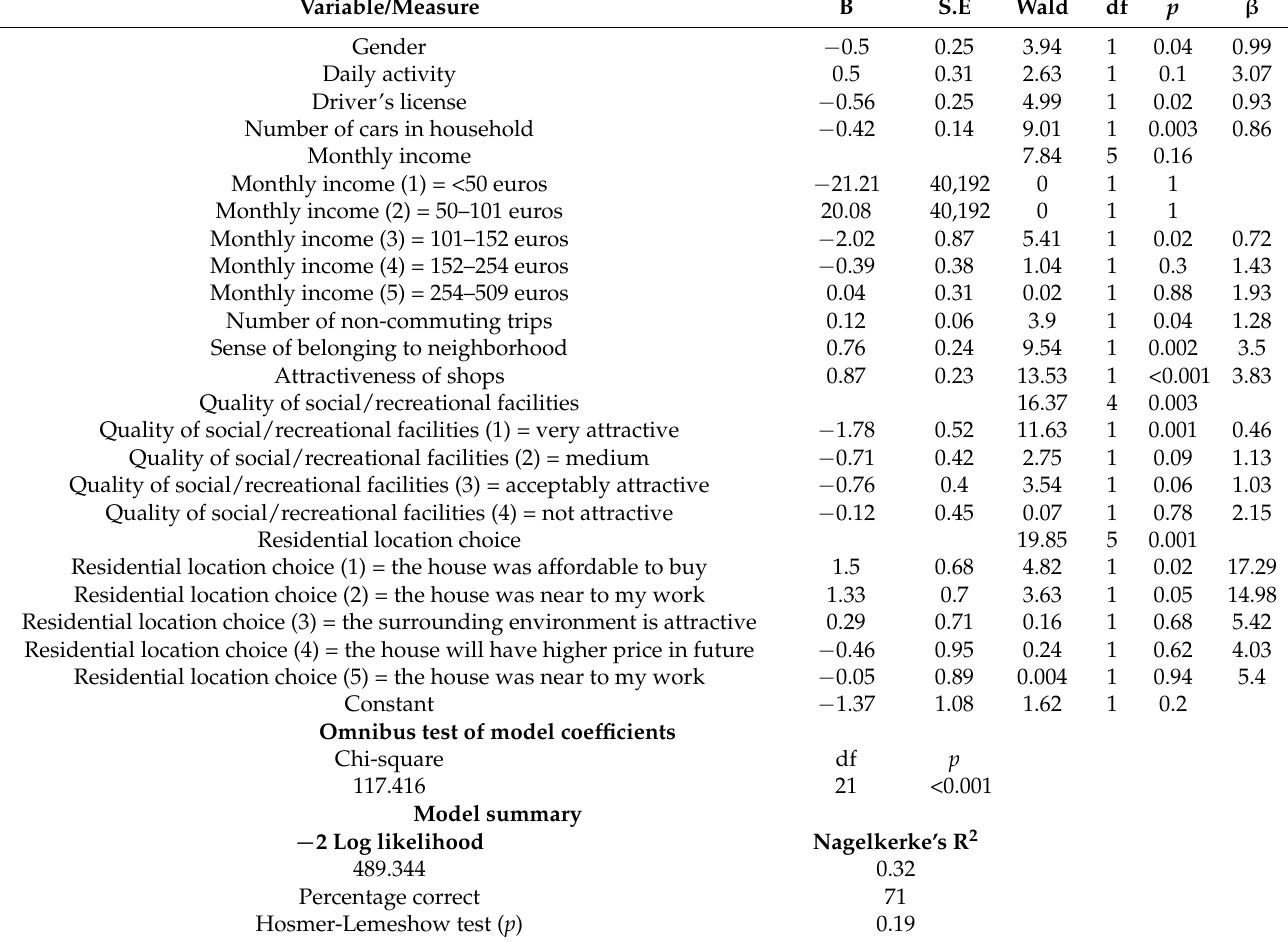
Table 8. Binary logistic model for choice of destination for entertainment for those living in sprawled districts Variable/Measure B